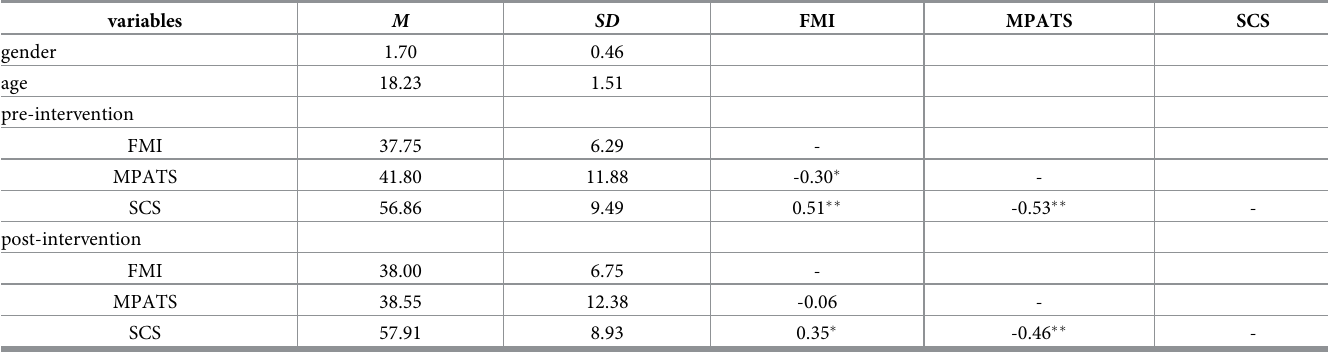
Table 2. Descriptive statistics and correlation test of the study